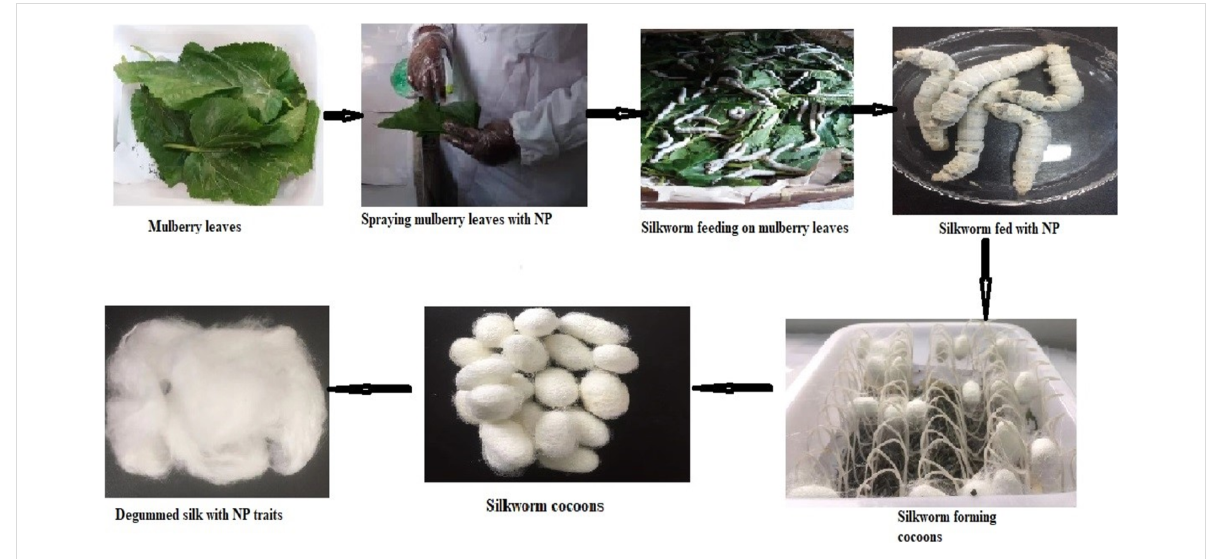
Figure 2: An illustration of how nanomaterials are directly fed to the silkworm. ©Sandra Senyo